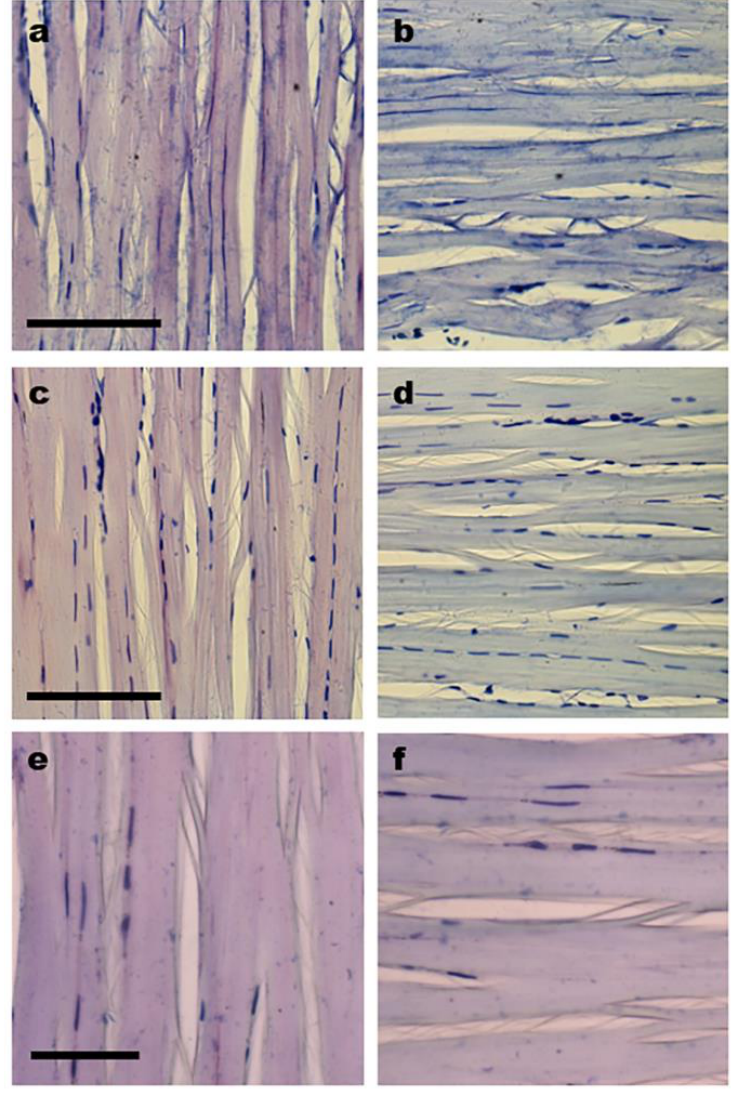
Figure 3. Negative LD in TB-stained tendon collagen bundles. Images representative of stained control tendons ( a , b ) and tendons cultivated for 8 ( c , d ) and 12 ( e , f ) days on glass coverslips ( c – f ). The long axes of the tendons were positioned perpendicular ( a , c , e ) (violet color) and parallel ( b , d , f ) (blue color) to the PPL. Images e and f were obtained for zones distal to the region originally occupied by the enthesis in vivo. The LD phenomenon is maintained in cultivated tendons, although it exhibits slightly less intense colors in comparison with control tendons. Scale bars equal 50 µm.